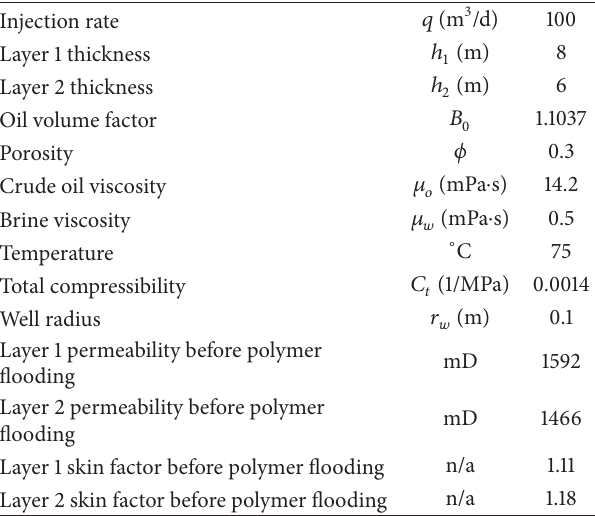
Figure 11: Field test data and history matching of type curves (Field Test One: Well 5-227). Table 5: Basic parameters of well and reservoir for 5-227 field test.